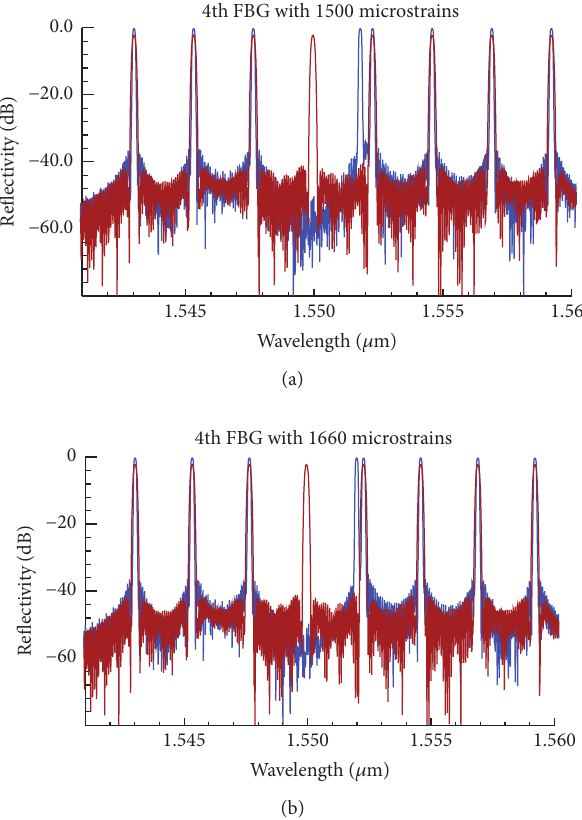
Figure 15: Strain effect on the 4th optimized